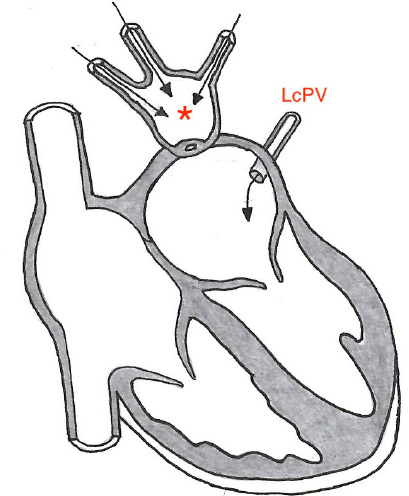
Figure 7. Diagram showing the collecting dilated structure attached to the LA (red *) and the PVs draining the left caudal, accessory, right caudal, and the right cranial lung lobe emptying into the dilated common structure. The normal PV draining the left cranial lung lobe (LcPV) empty via the ostium in the left LA-wall. LA: left atrium, LcPV: Left cranial lung lobe, PV: pulmonary vein.